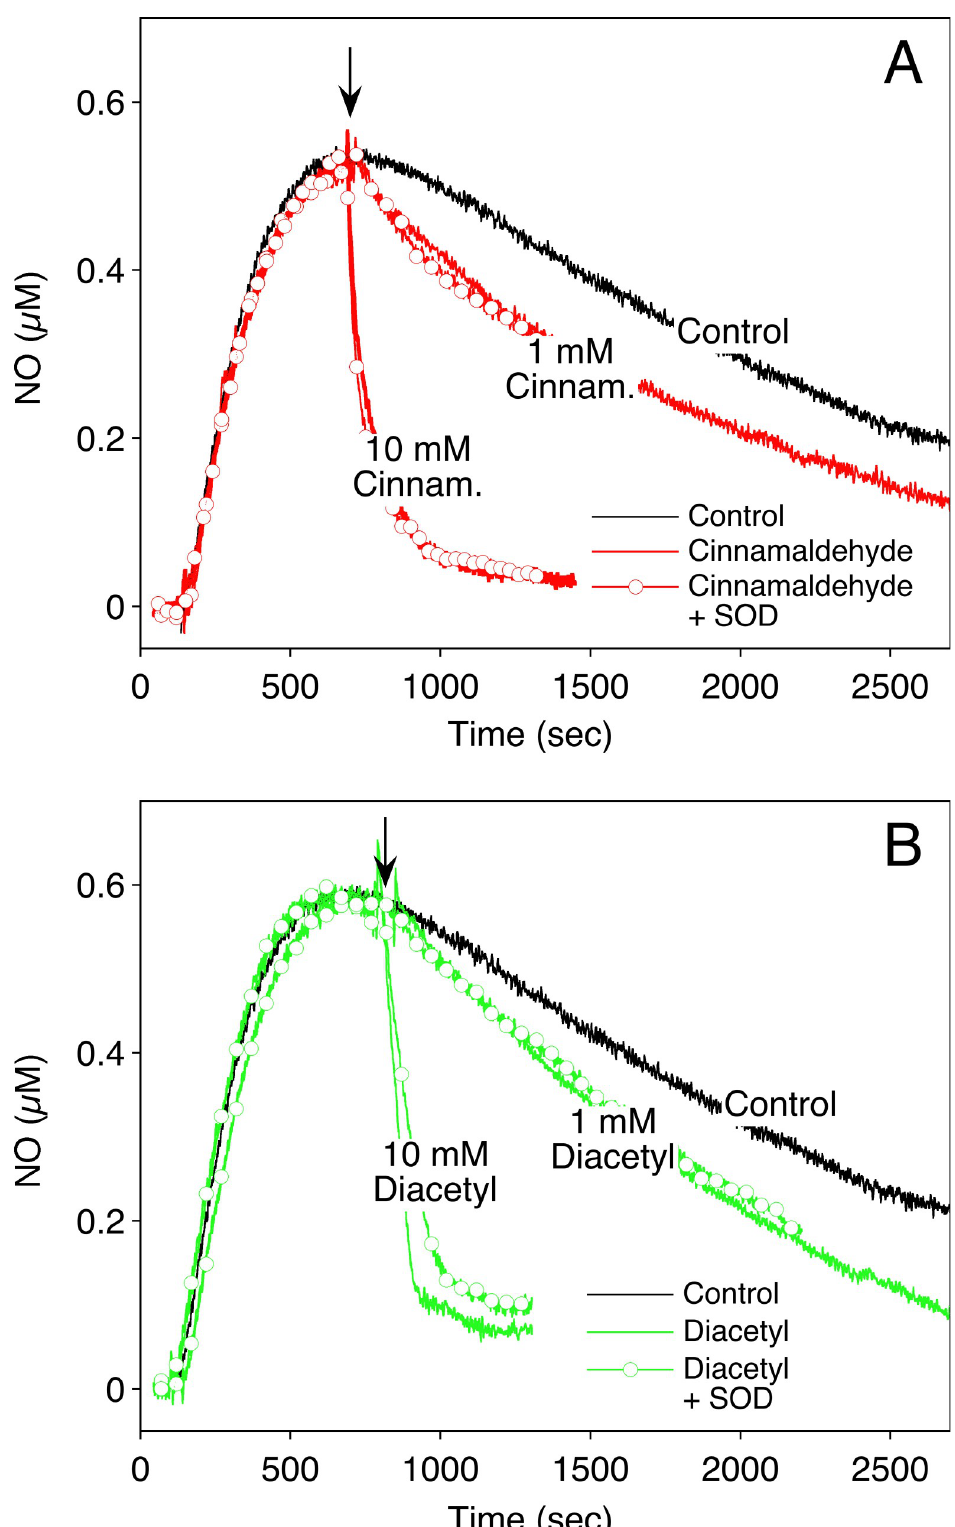
Fig 5. Inactivation of NO by cinnamaldehyde (A) and diacetyl (B). NO formation was induced by adding DEA/NO (final concentration 1 μ M) to 100 mM phosphate buffer, pH 7.4. At time points indicated by arrows, cinnamaldehyde or diacetyl was added. Experiments performed in the presence of SOD (2500 U/ml) are marked with open circles. Original traces each representative for 3 experiments are shown. https://doi.org/10.1371/journal.pone.0222152.g005 PLOS ONE | https://doi.org/10.1371/journal.pone.0222152 September 9,